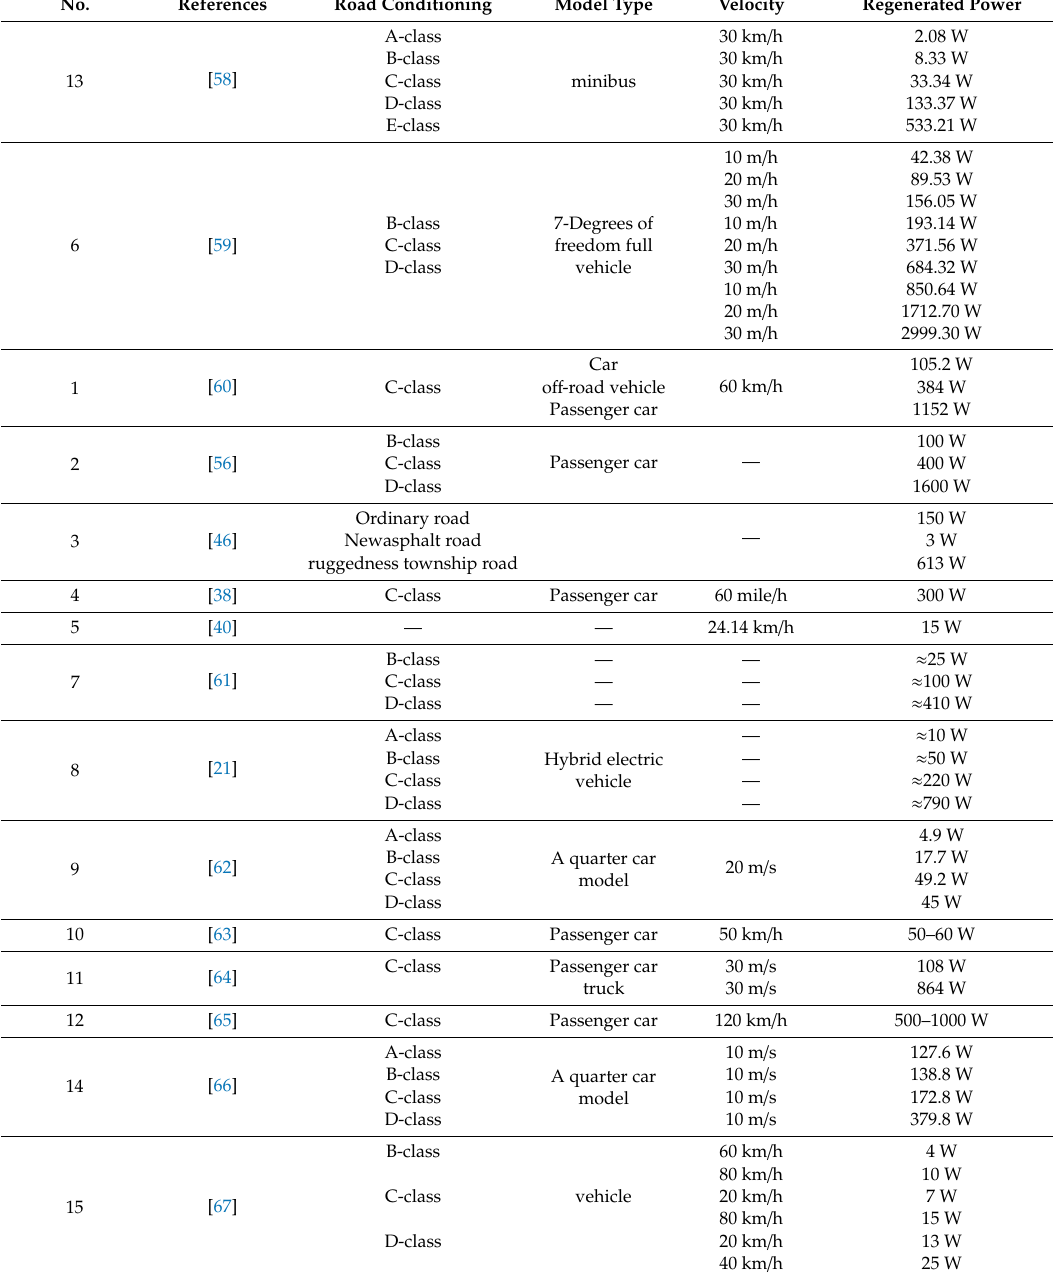
Table 1. Survey of the conducted simulation-based investigations in terms of energy-regenerative-based shock